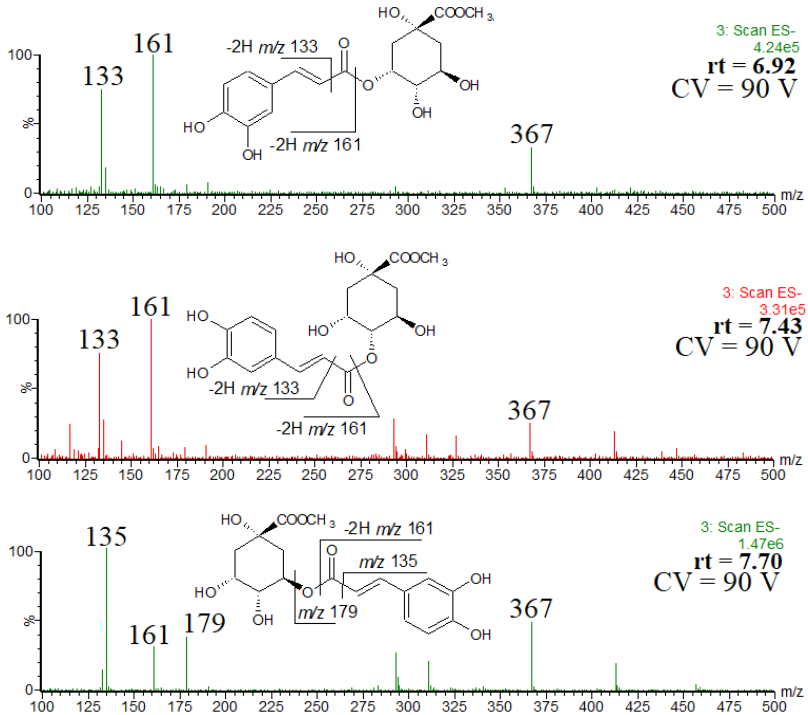
Figure 4. ESI mass spectra of methyl chlorogenate and its isomers, and the observed fragmentation patterns.